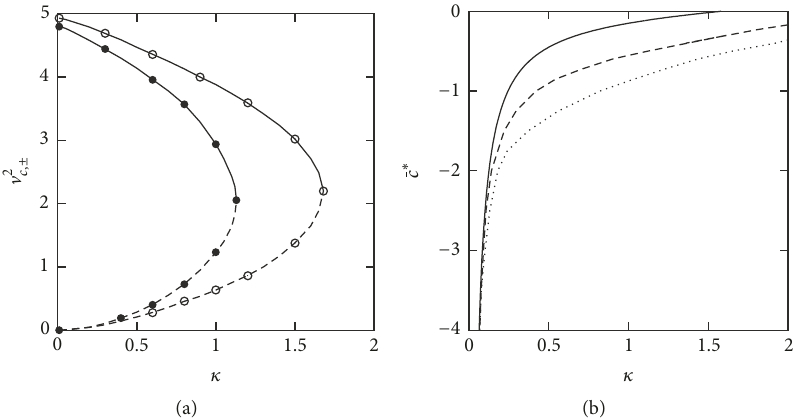
Figure 11: Dependence of the critical velocity V 𝑐,± and 𝑐 ∗ on 𝜅 . Data are obtained by the simulation of the full tensor model. 𝑏 𝑠 = 0.1 . (a) Dependence of V 2 𝑐,± on 𝜅 . 𝑐 = −0.5 . The curves with filled ( ∙ ) and open ( ∘ ) circles correspond to the cases of 𝑏 1 = 0.25 and 𝑏 1 = 0.5 , respectively. The solid and dashed curves represent V 2 𝑐,− and V 2 𝑐,+ , respectively. (b) Dependence of 𝑐 ∗ on 𝜅 . 𝑏 𝑠 = 0.1 . The solid, dashed, and dotted curves correspond to the cases of 𝑏 1 = 0 , 0.25, and 0.5,